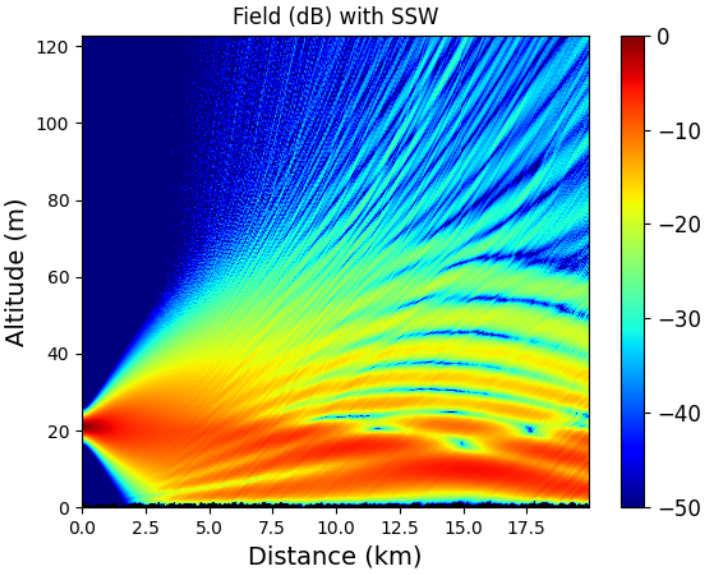
Figure 15. Worst-case scenario for the antenna coverage computed with the SSW method. In this case the source is placed z s = 20 m above the